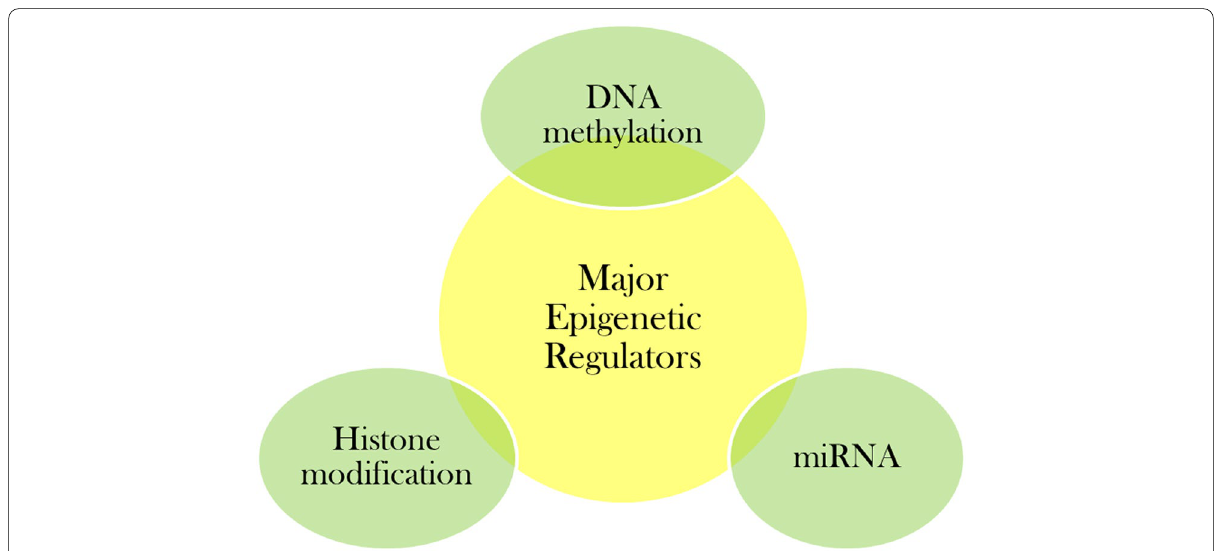
Fig. 2 Major epigenetic